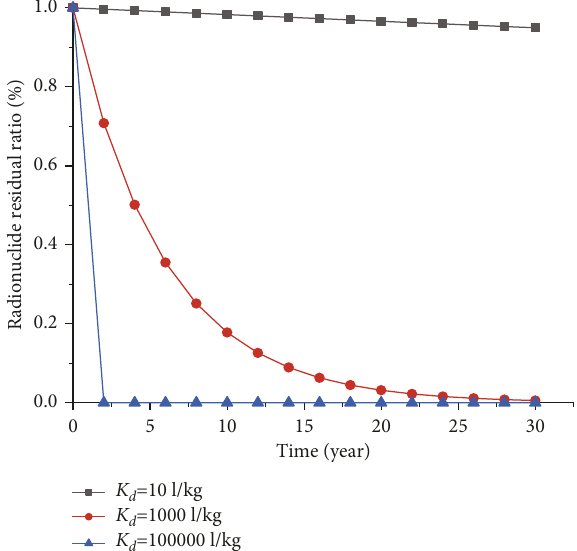
Figure 6: Radionuclide residual ratio change with time with upper limit values of parameters.